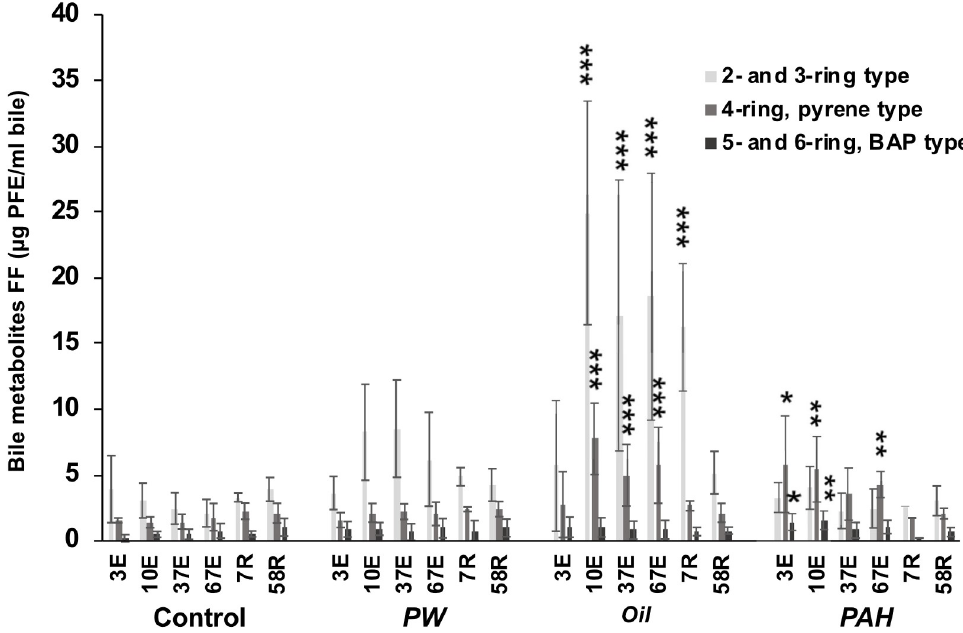
Fig 6. Fixed wavelength fluorescence (FF) analysis of PAH bile metabolites. FF were measured at the 290/334 nm (2/3 ring-type), P341/383 nm (pyrene-type) and 380/430 nm (benzo[ a ]pyrene-type). From the different treatments groups, control (C), produced water (PW), oil extracts (Oil) and heavy PAH mixture (PAH) after 3 day (3E), 10 days (10E), 37 days (37E) and 67 days (67E) of oral exposure, and after 7 days (7R) and 58 days (58R) recovery. Data presented as means ( ± SD). Asterisks indicate statistical difference relative to the control fish (ANOVA). P < 0.05 = � , P < 0.01 = �� , P < 0.001 = ��� .